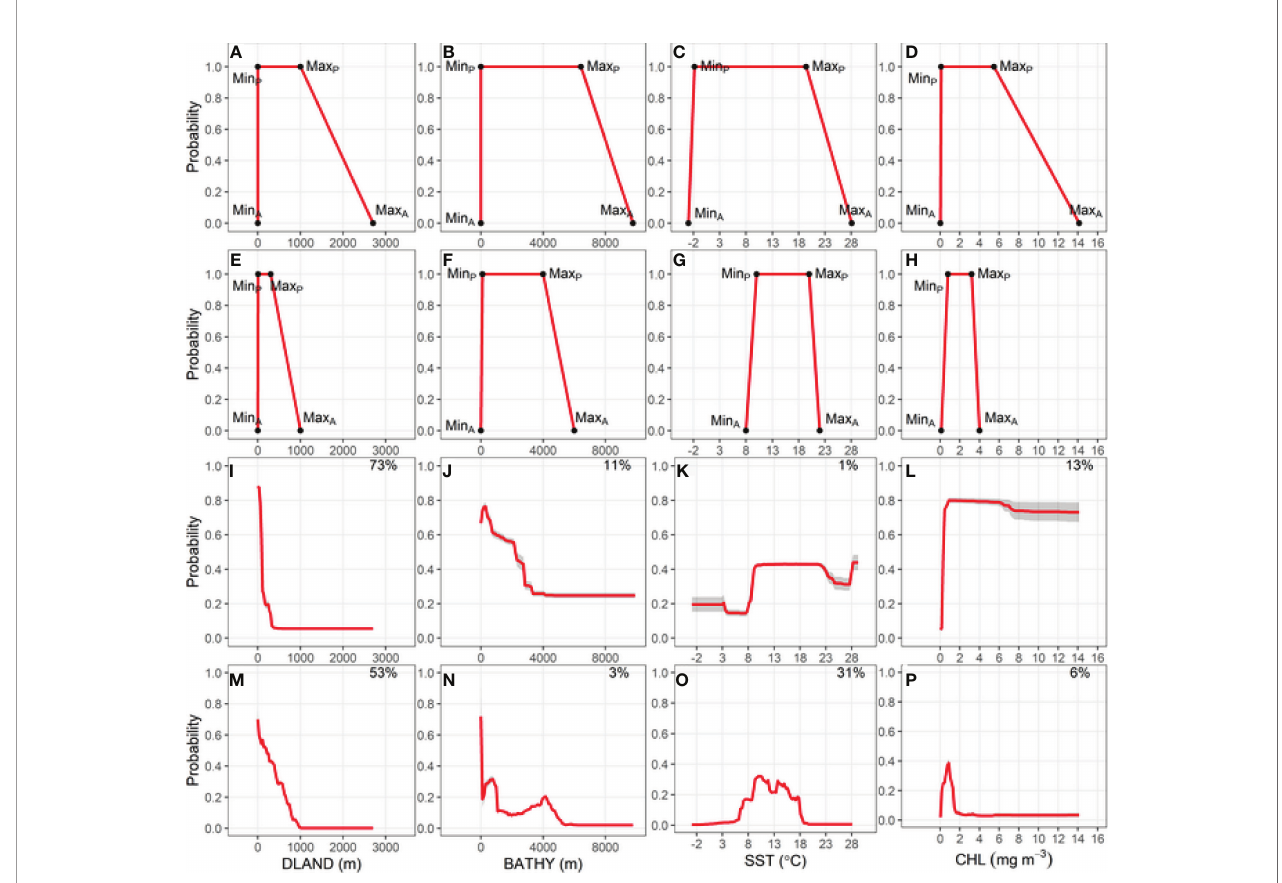
FIGURE 2 | Relationship between the probability of Buller ’ s albatross occurrence and four environmental variables: Bathymetry (BATHY), distance from land (DLAND), sea surface temperature (SST) and chlorophyll-a (CHL). Top two rows show trapezoidal response curves for each environmental variable used in two Relative Environmental Suitability models (one fi t with values obtained from the monthly 50% kernel density contours from geolocation data and background environmental data [RES KERN, (A – D) ], and one fi t with values from the literature and expert opinion [RES LIT , (E – H) ]. Minimum and maximum absolute and preferred habitat values are denoted by Min A , Max A , Min P , and Max P . Bottom two rows show partial dependence plots for each environmental variable from two bootstrapped Boosted Regression Tree models (one fi t with opportunistic sightings data [BRT OS , (I – L) ], and one fi t with geolocation data [BRT GL , (M – P) ]. Red lines represent response curves with grey shading showing the standard deviation. Percentage contribution for each variable is shown on the top right